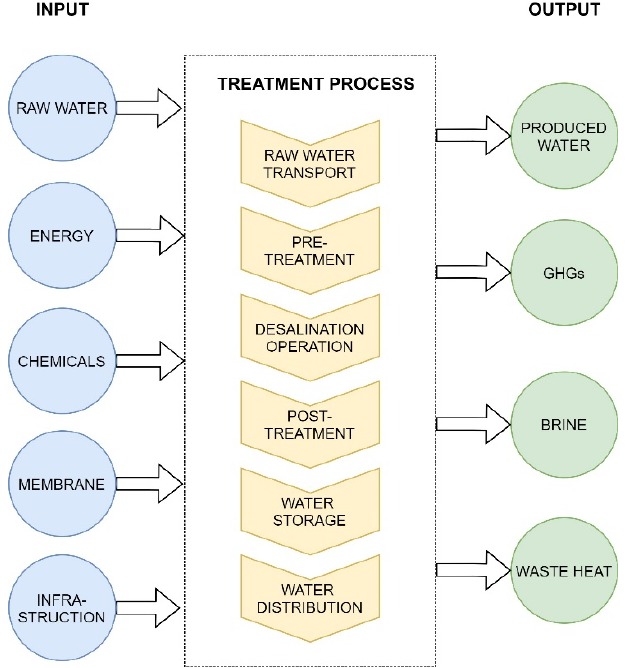
Figure 7. Flow chart of the desalination process, amended from [57] .